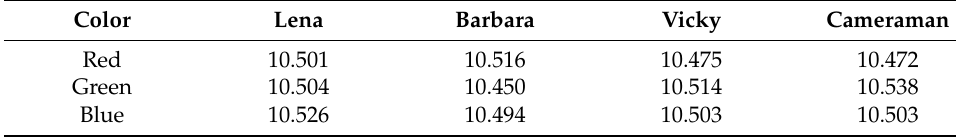
Table 9. Contrast of Figure 1 images after encryption.